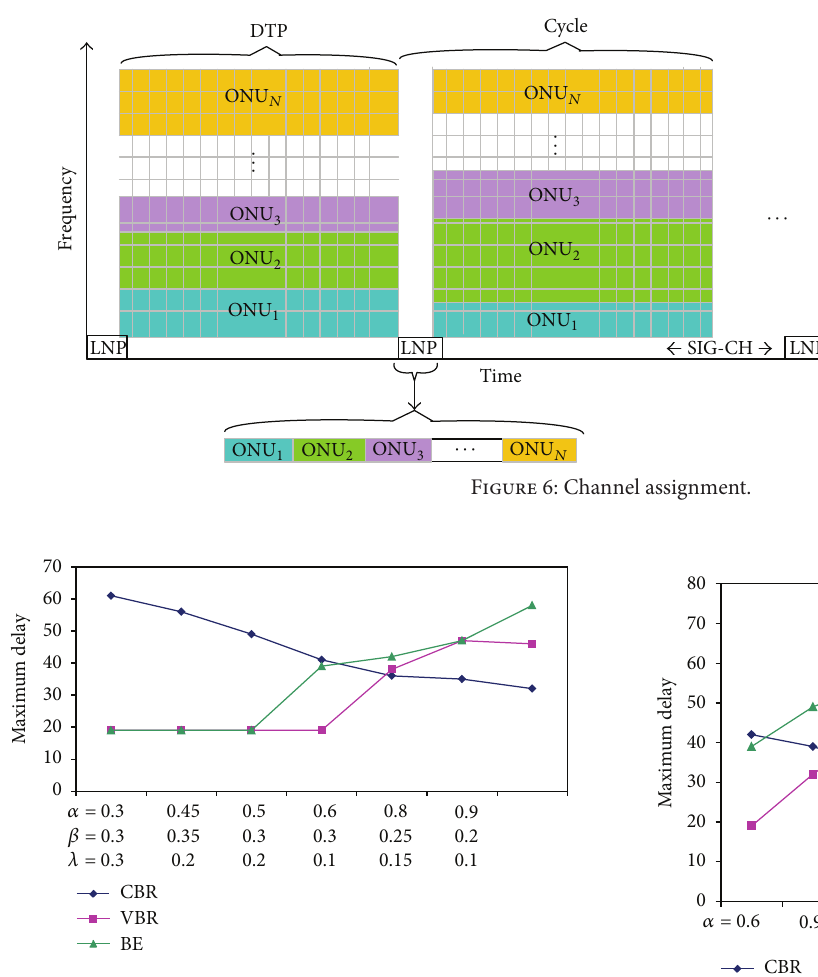
Figure 7: Maximum delay suffered due to different combinations of (𝛼,𝛽,𝜆) triple.